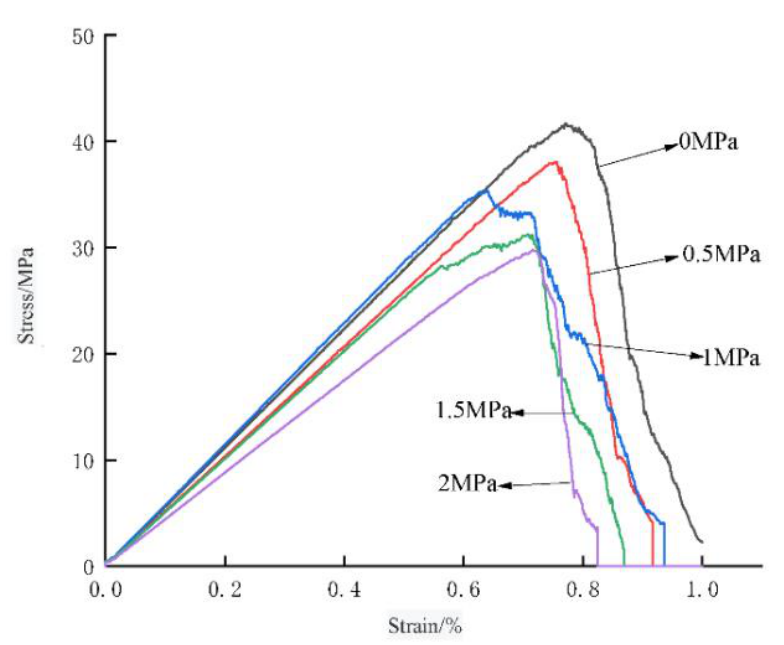
Figure 7. Stress and strain curves of coal samples under uniaxial compression with different gas pressures.